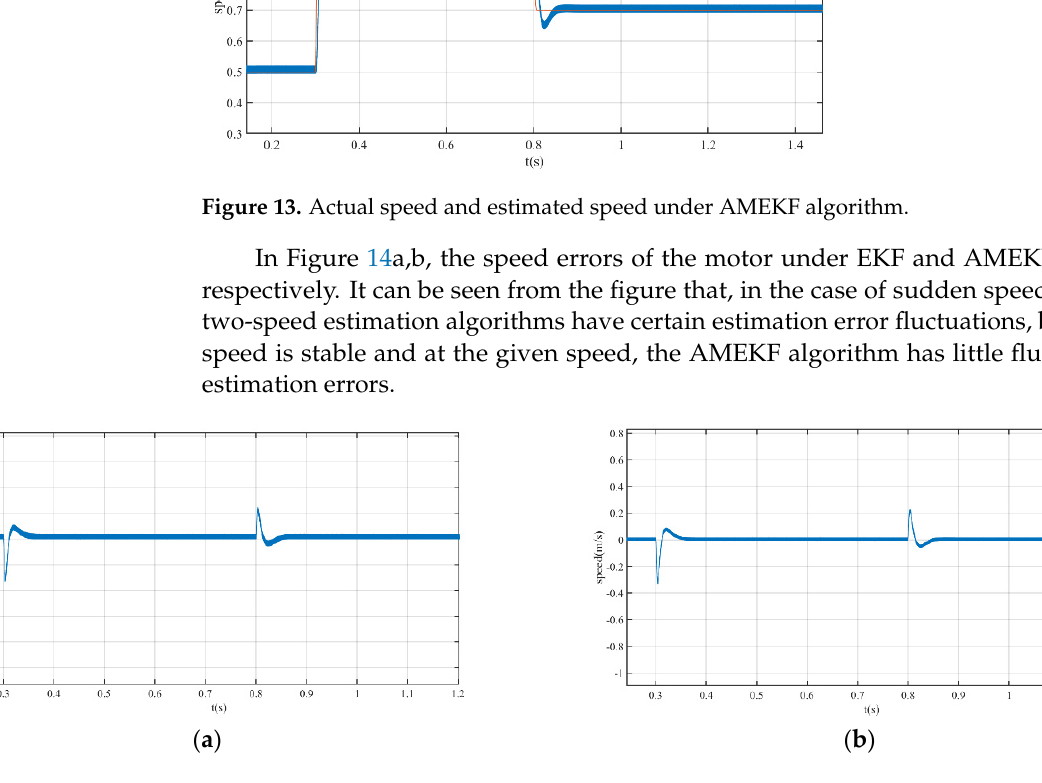
Figure 14. Speed estimation error. ( a ) EKF velocity estimation error. ( b ) AMEKF velocity estimation error.